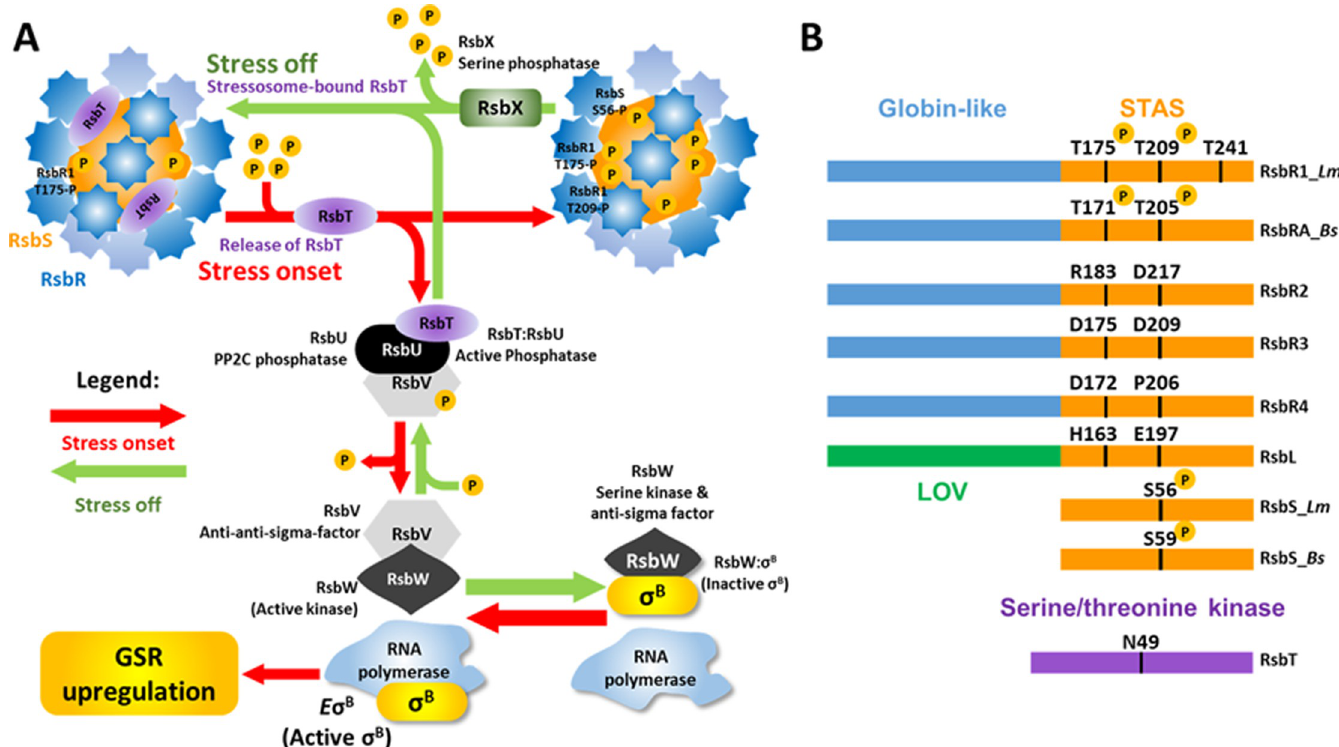
Fig 1. Model depicting the stressosome-mediated regulation of σ B and alignment of stressosome proteins. (A) The putative sensory proteins RsbR1 and its paralogues RsbR2, RsbR3, RsbL, the scaffold protein RsbS and the serine-threonine kinase RsbT form the stressosome. Environmental/nutritional stress is hypothesized to be sensed by one or more RsbR1 paralogue via its N-terminal non-haem binding globin domains forming the turrets at the stressosome surface (blue). The stressosome core (orange) is composed of the STAS domains of both RsbS and RsbR1 C-termini. Stress triggers T209 phosphorylation in RsbR1 and S56 in RsbS, freeing RsbT (purple) from the stressosome core. The phosphatase RsbU interacts with the free RsbT, activating its phosphatase activity towards RsbV. Once dephosphorylated, the serine kinase and anti-sigma factor RsbW, which has higher affinity with the non-phosphorylated RsbV, releases σ B and phosphorylates RsbV once more. σ B is then able to interact with the RNApol forming the holoenzyme E σ B enabling the upregulation of the general stress regulon. The phosphatase RsbX is responsible for the deactivation of the stressosome by dephosphorylating its residues and enabling the re-sequestration of RsbT and the inactivation of the signal cascade. The model shown incorporates the current available data from studies on both Listeria and Bacillus (see text for citations). (B) Domain organization of L . monocytogenes RsbR1_ Lm and its paralogues, RsbS_ Lm and RsbT and B . subtilis RsbRA_ Bs and RsbS_ Bs . The N-terminal domains of RsbR1 and paralogues fold into non-haem binding globin-like domains that form the stressosome turrets, while the blue-light sensor RsbL folds into an LOV domain. The C-termini of RsbR1 and paralogues fold into STAS domains forming the stressosome core along with RsbS. The serine-threonine kinase RsbT responsible for the stressosome phosphorylation requires the ATP-Mg 2+ chelating residue N49 for its kinase